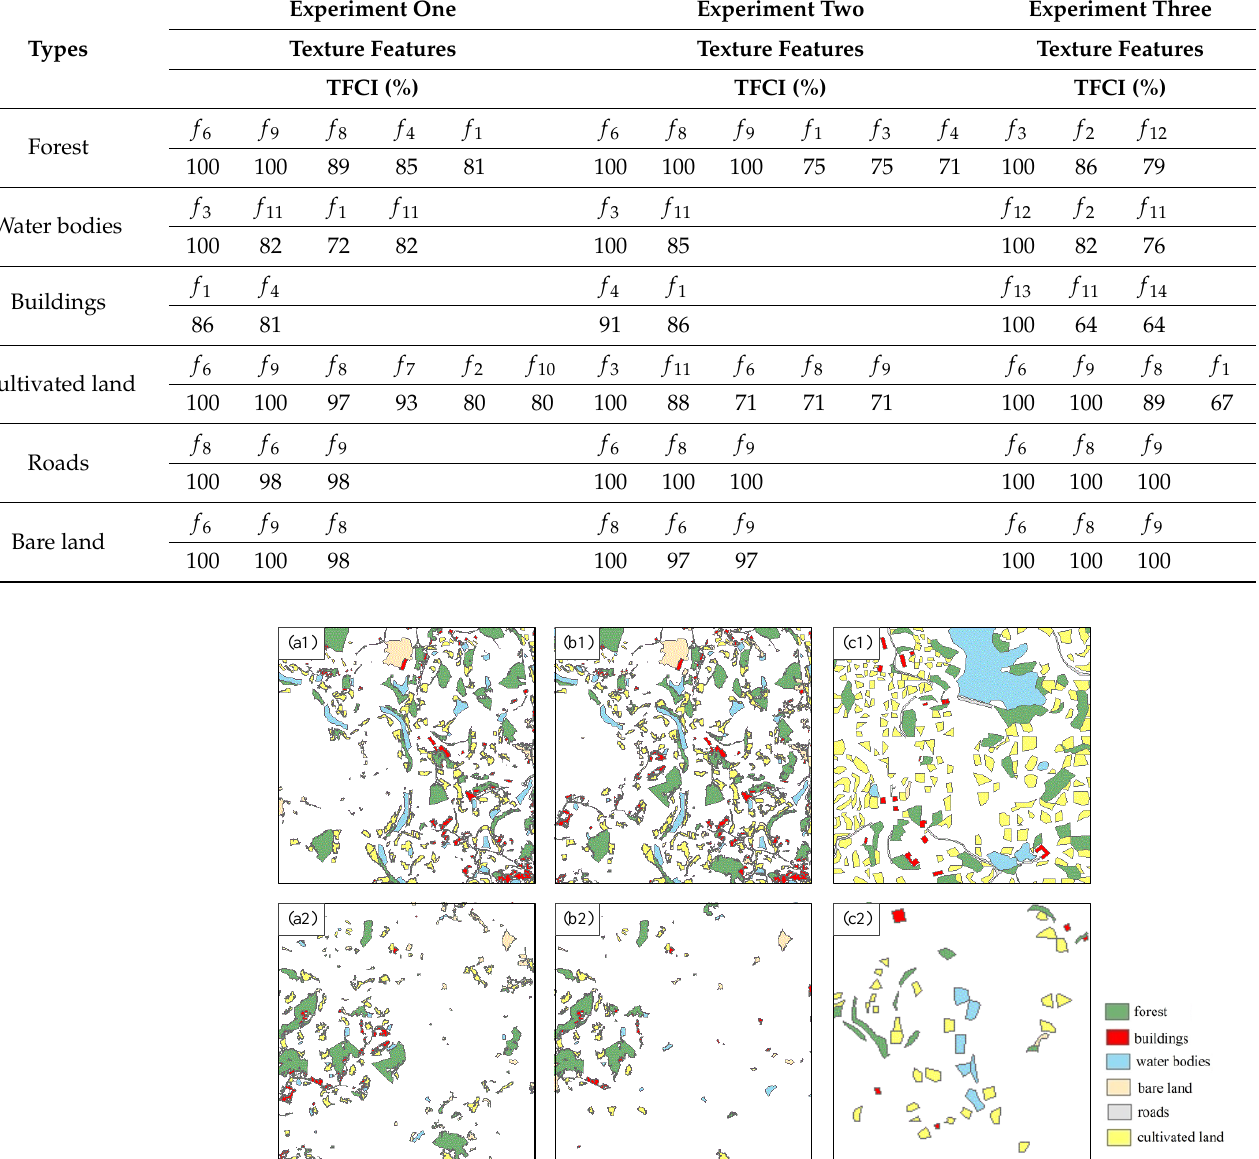
Table 3. The results of texture feature selection for six types of surface objects in the three experiments.